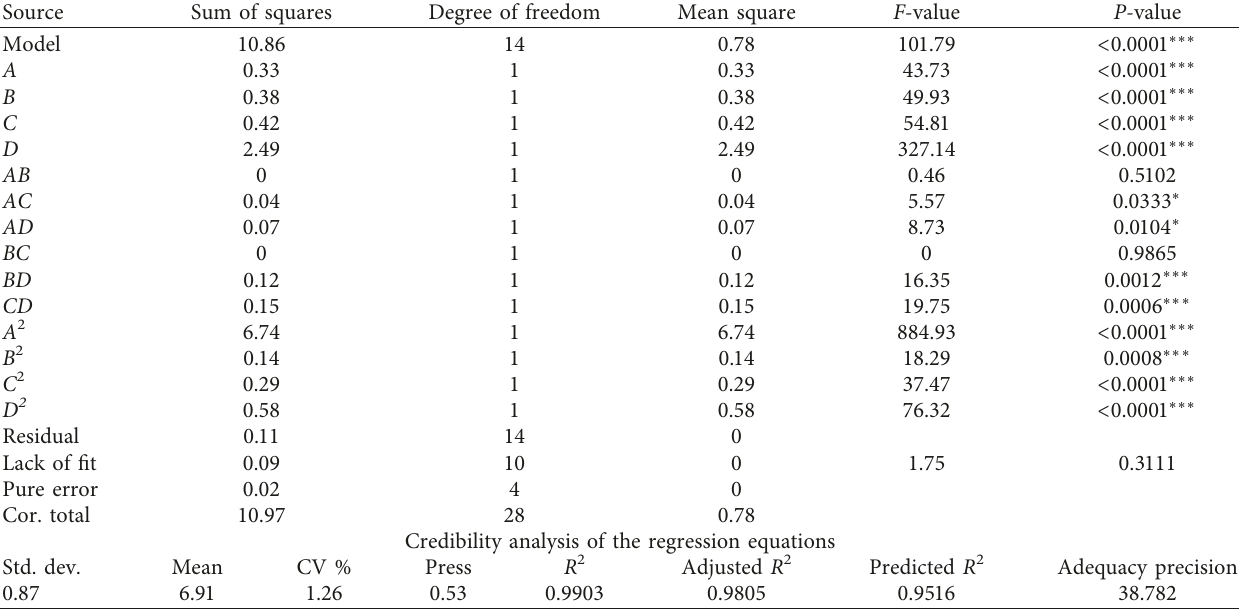
Table 2: Analysis of variance (ANOVA) for the fitted quadratic model of C. camphora flavonoids extraction determined from Box–Behnken